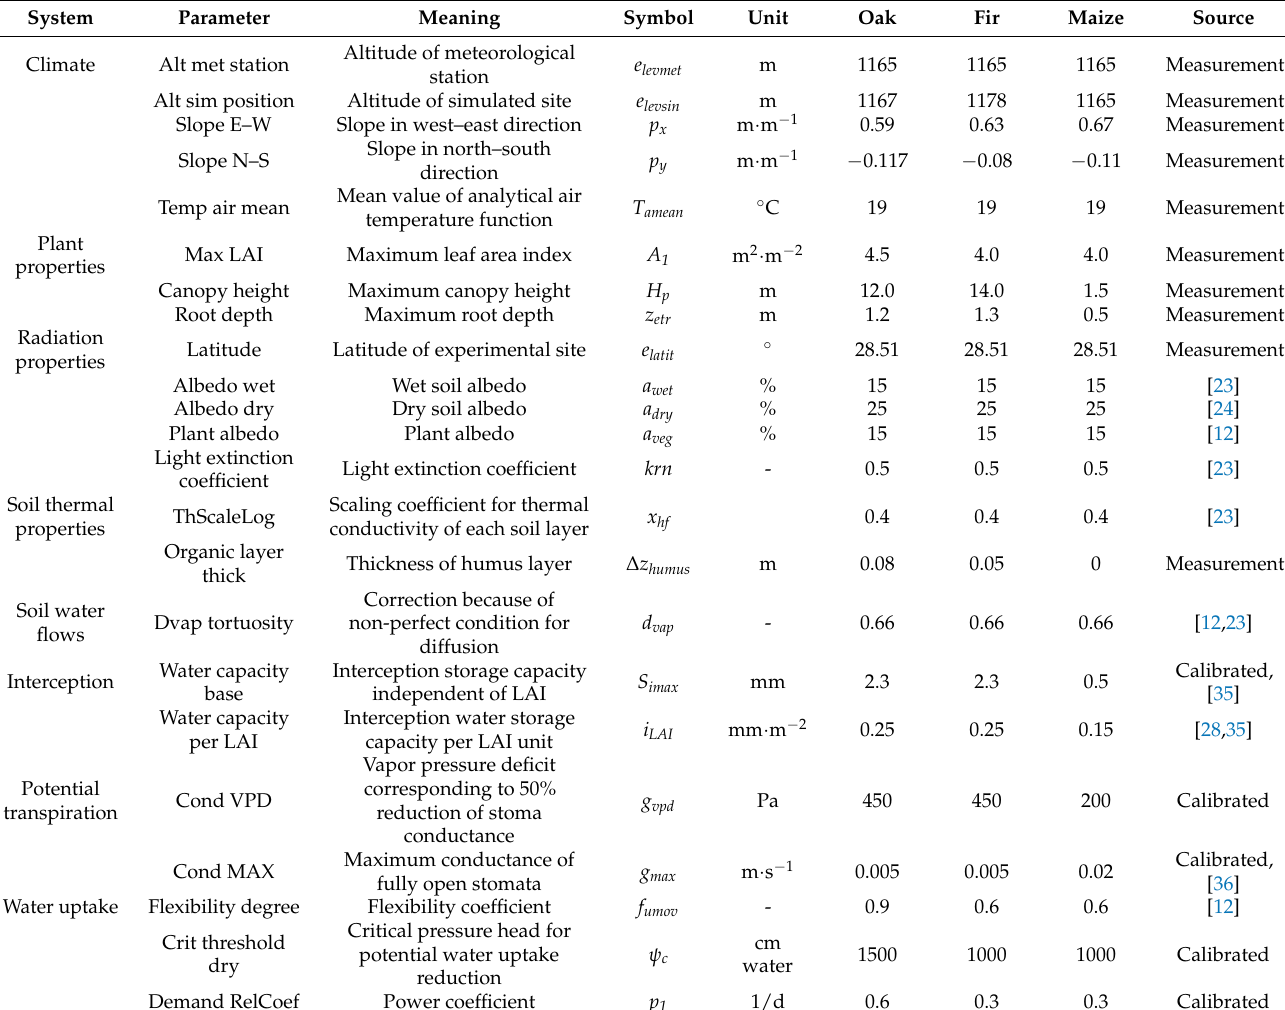
Table 2. Parameter values adjusted in